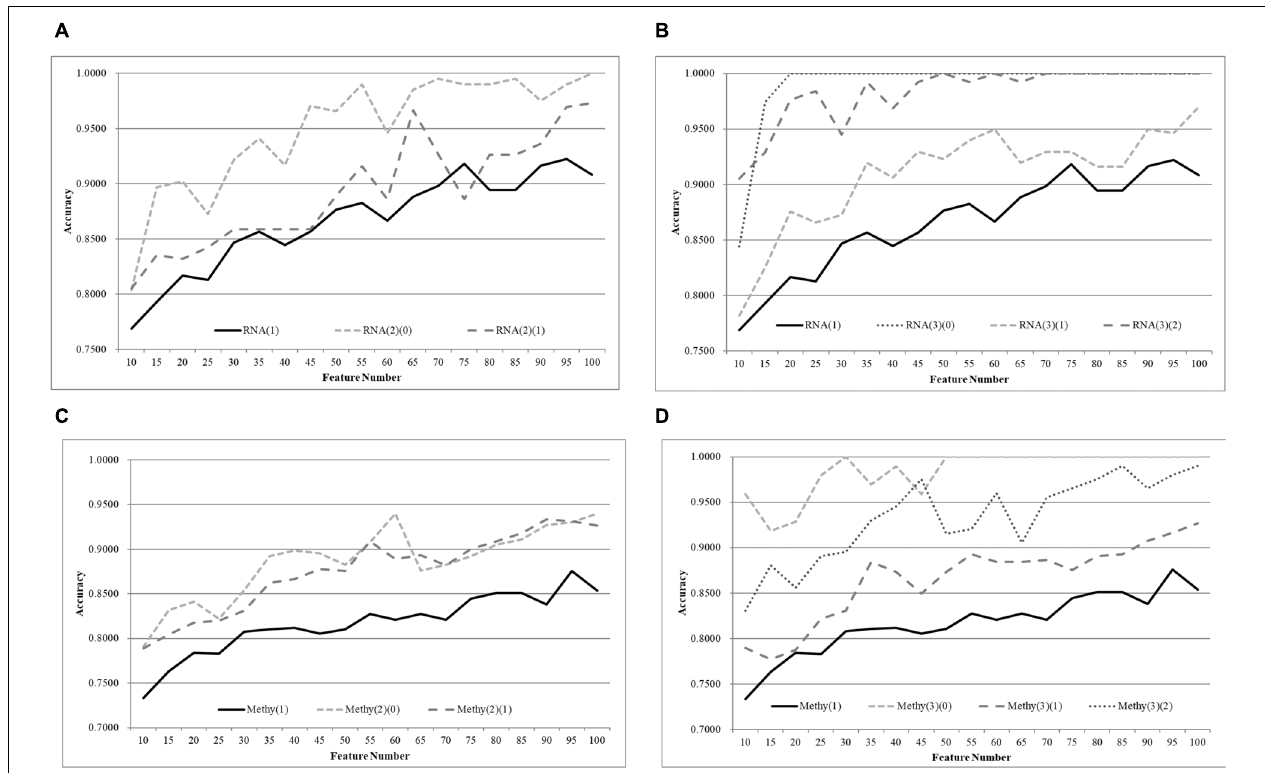
FIGURE 10 | Comparison of early-stage breast cancer detection models with different age groups based on both transcriptome and methylome data using the classifier SVM on the dataset TCGA-HNSC. Transcriptomes of the patients were split into (A) two groups and (B) three groups with equally-sized age ranges. The methylomes were split into (C) two groups and (D) three groups in the same way. The horizontal axis shows the numbers of features chosen by rfeSVM and the vertical axis shows the 10-fold cross-validation accuracy of the classifier SVM on the independent test dataset. F -test was used to generate the initial subset of the 1000 top-ranked